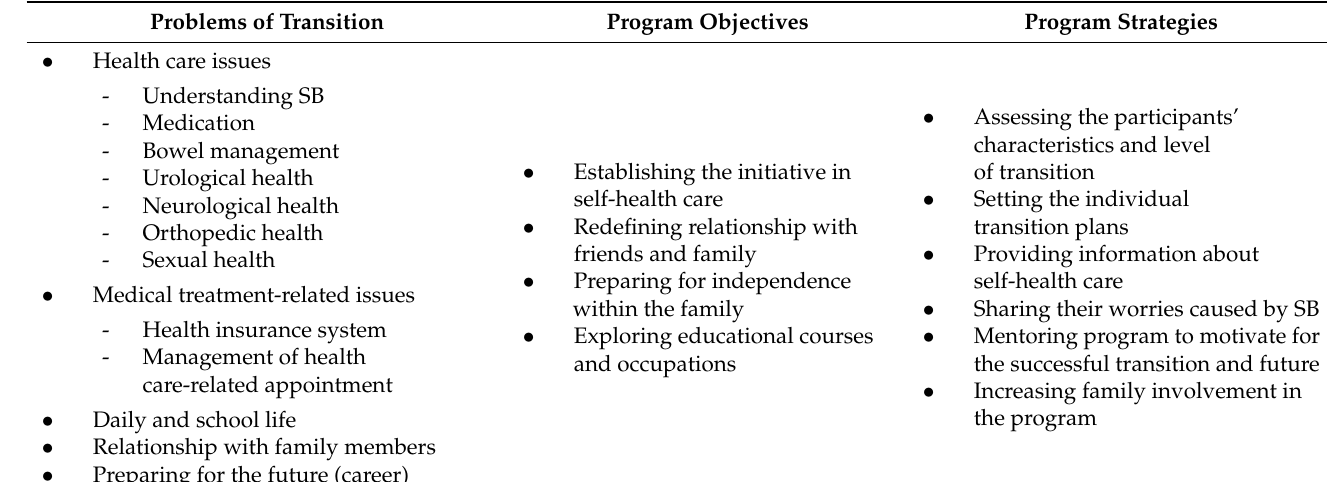
Table 1. The problems of transition, program objectives, and program